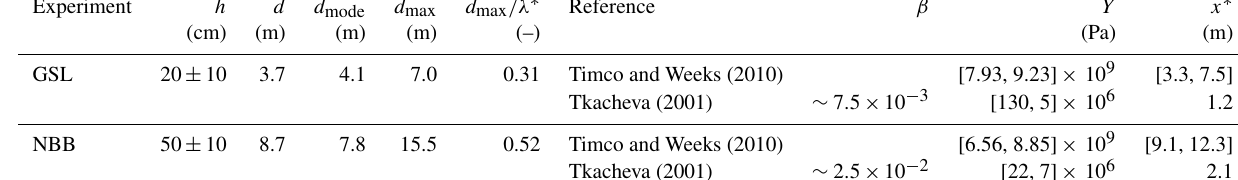
Table 2. Physical quantities related to the AFSDs and comparison to x ∗ with different approaches to estimate the sea ice Young’s modulus. Experiment